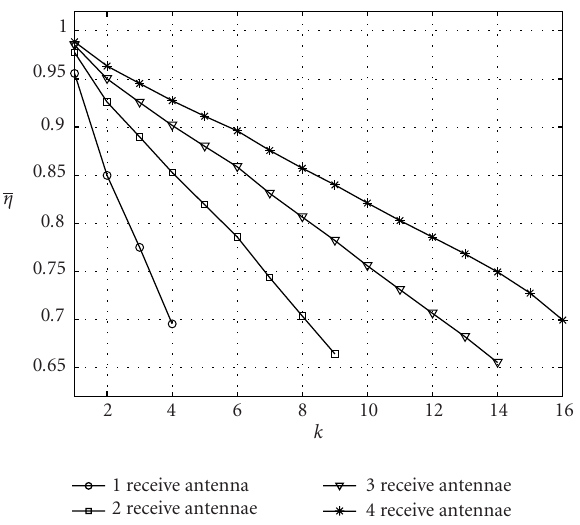
Figure 4: Lower bound for the average near-far resistance of the two-stage receiver versus the number of users for several n r : M = 8, N = 4, and n t = 2 .